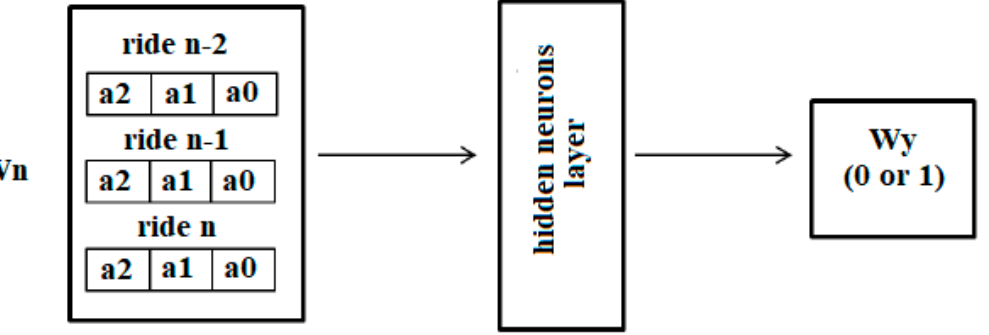
Figure 4. Diagram of a neural network using second degree polynomial coefficients for learning. a2, a1, a0—polynomial coefficients characterizing specific drives, Wy—operator assessment result: 0— not trained, 1—trained.